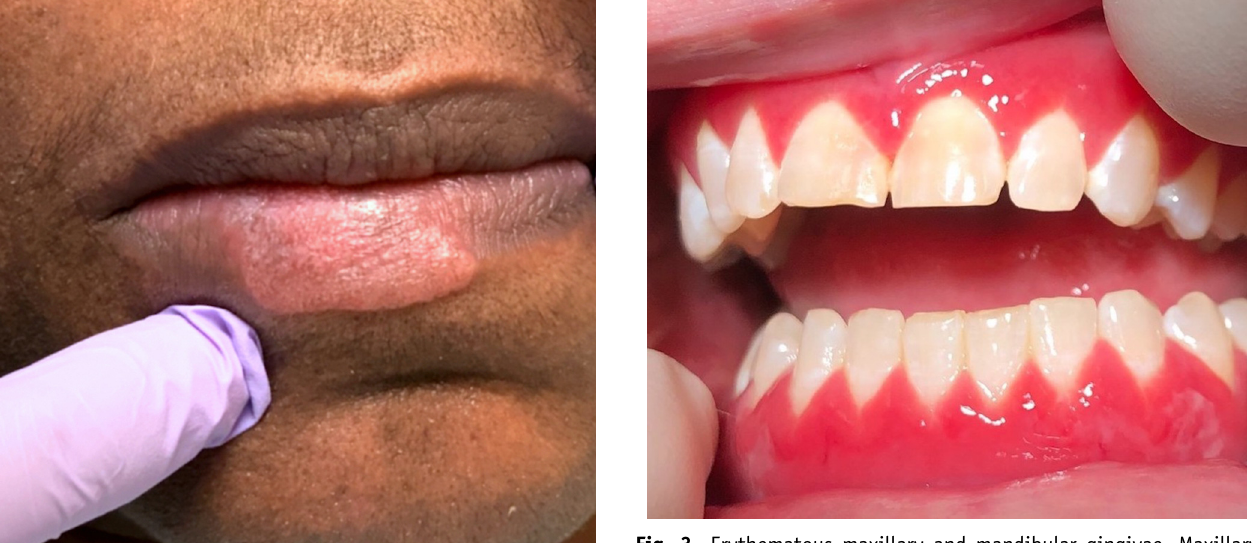
Fig. 3. Erythematous maxillary and mandibular gingivae. Maxillary gingivae are enlarged and erythematous. Mandibular gingivae are diffusely enlarged, erythematous, and focally ulcerated.